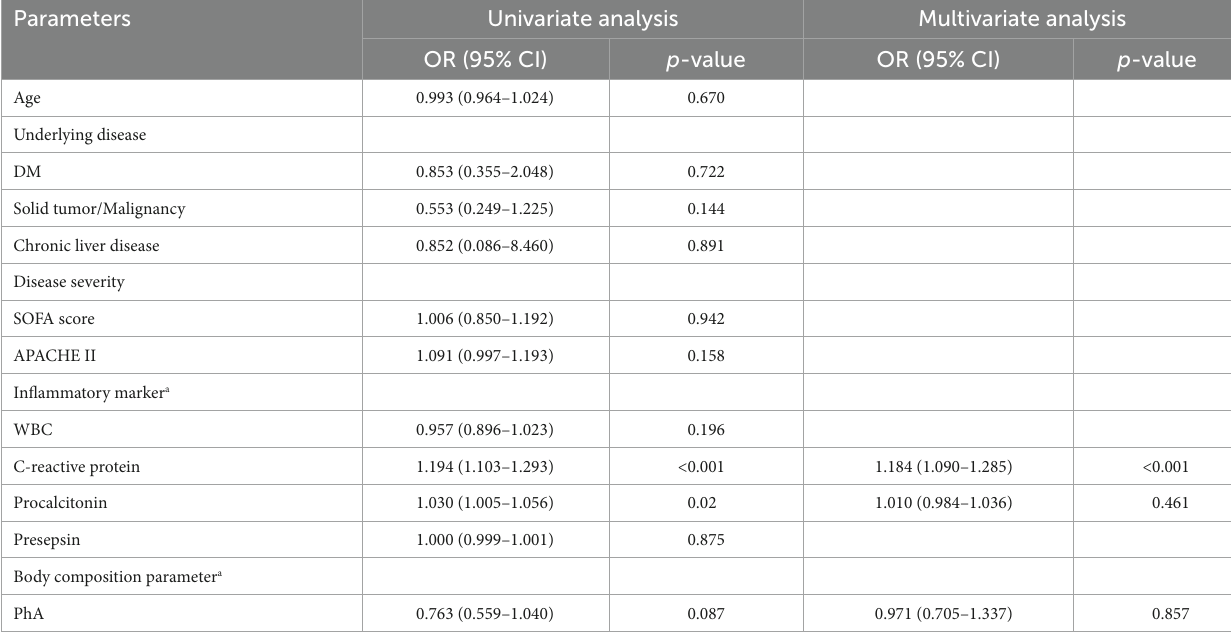
TABLE 3 Predictors of postoperative infections in patients who underwent abdominal surgery by univariate and multivariate logistic regression analysis in males . Parameters Univariate analysis Multivariate analysis